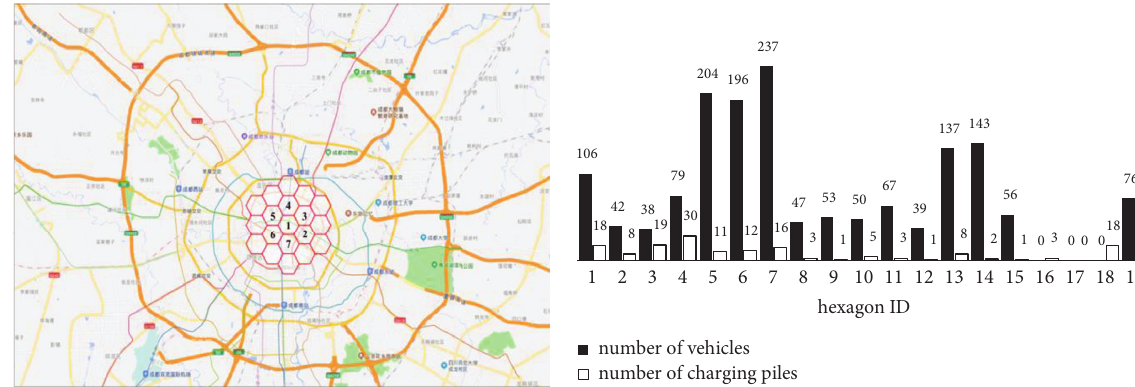
Figure 8: Regional division of inner ring of Chengdu, Sichuan, China.